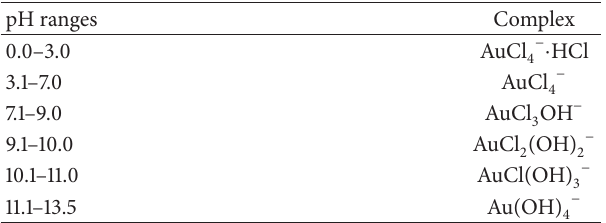
Table 7: Specification of Au (III) complexes formed after the addition of NaOH to a solution of chloroauric